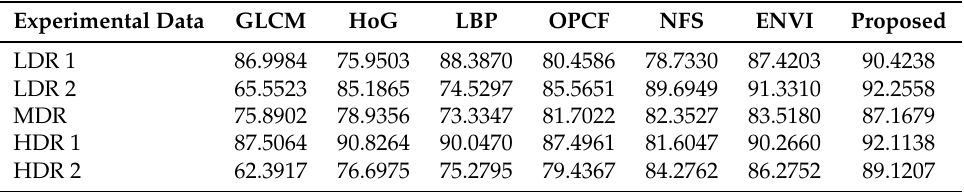
Table 3. Comparison of the experimental results with other methods for building extraction (%). OPCF, only point cloud features; NFS, no feature